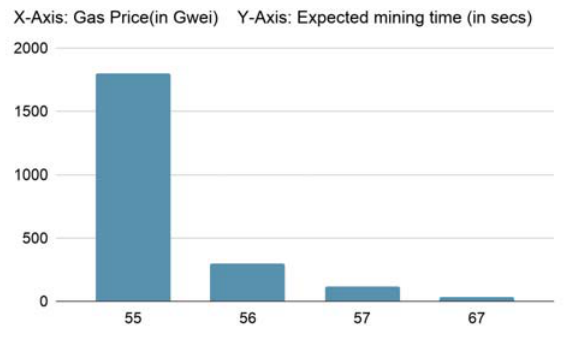
Fig 6. Gas Price v/s Mining Time